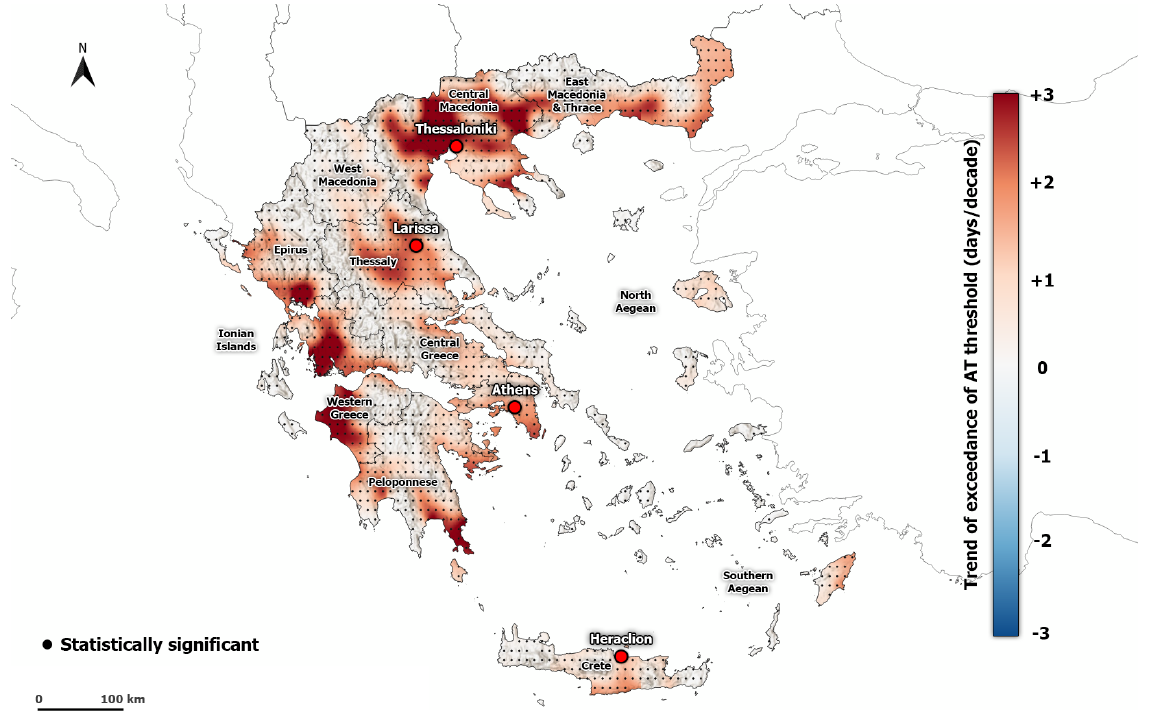
Figure 9. Spatial distribution of summer AT41C trend (days per decade) calculated from ERA5-Land during the period 1950–2020. Dots indicate significant trends at the 95% level.